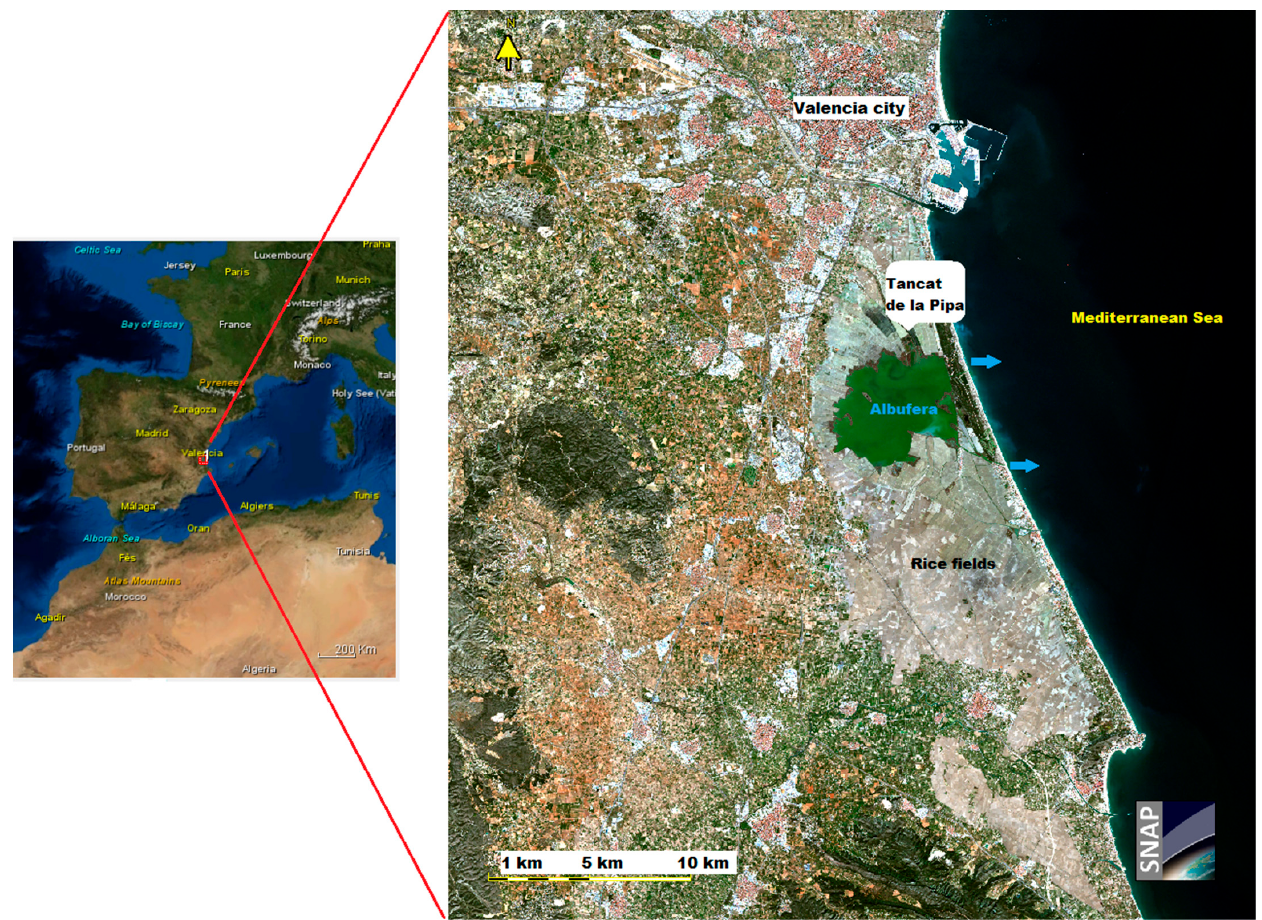
Figure 1. Location map of the Albufera of Valencia, indicating with blue arrows the outflow points of the water from the lagoon to the sea. Sentinel ‐ 2 false color RGB base image of 12 March 2019.